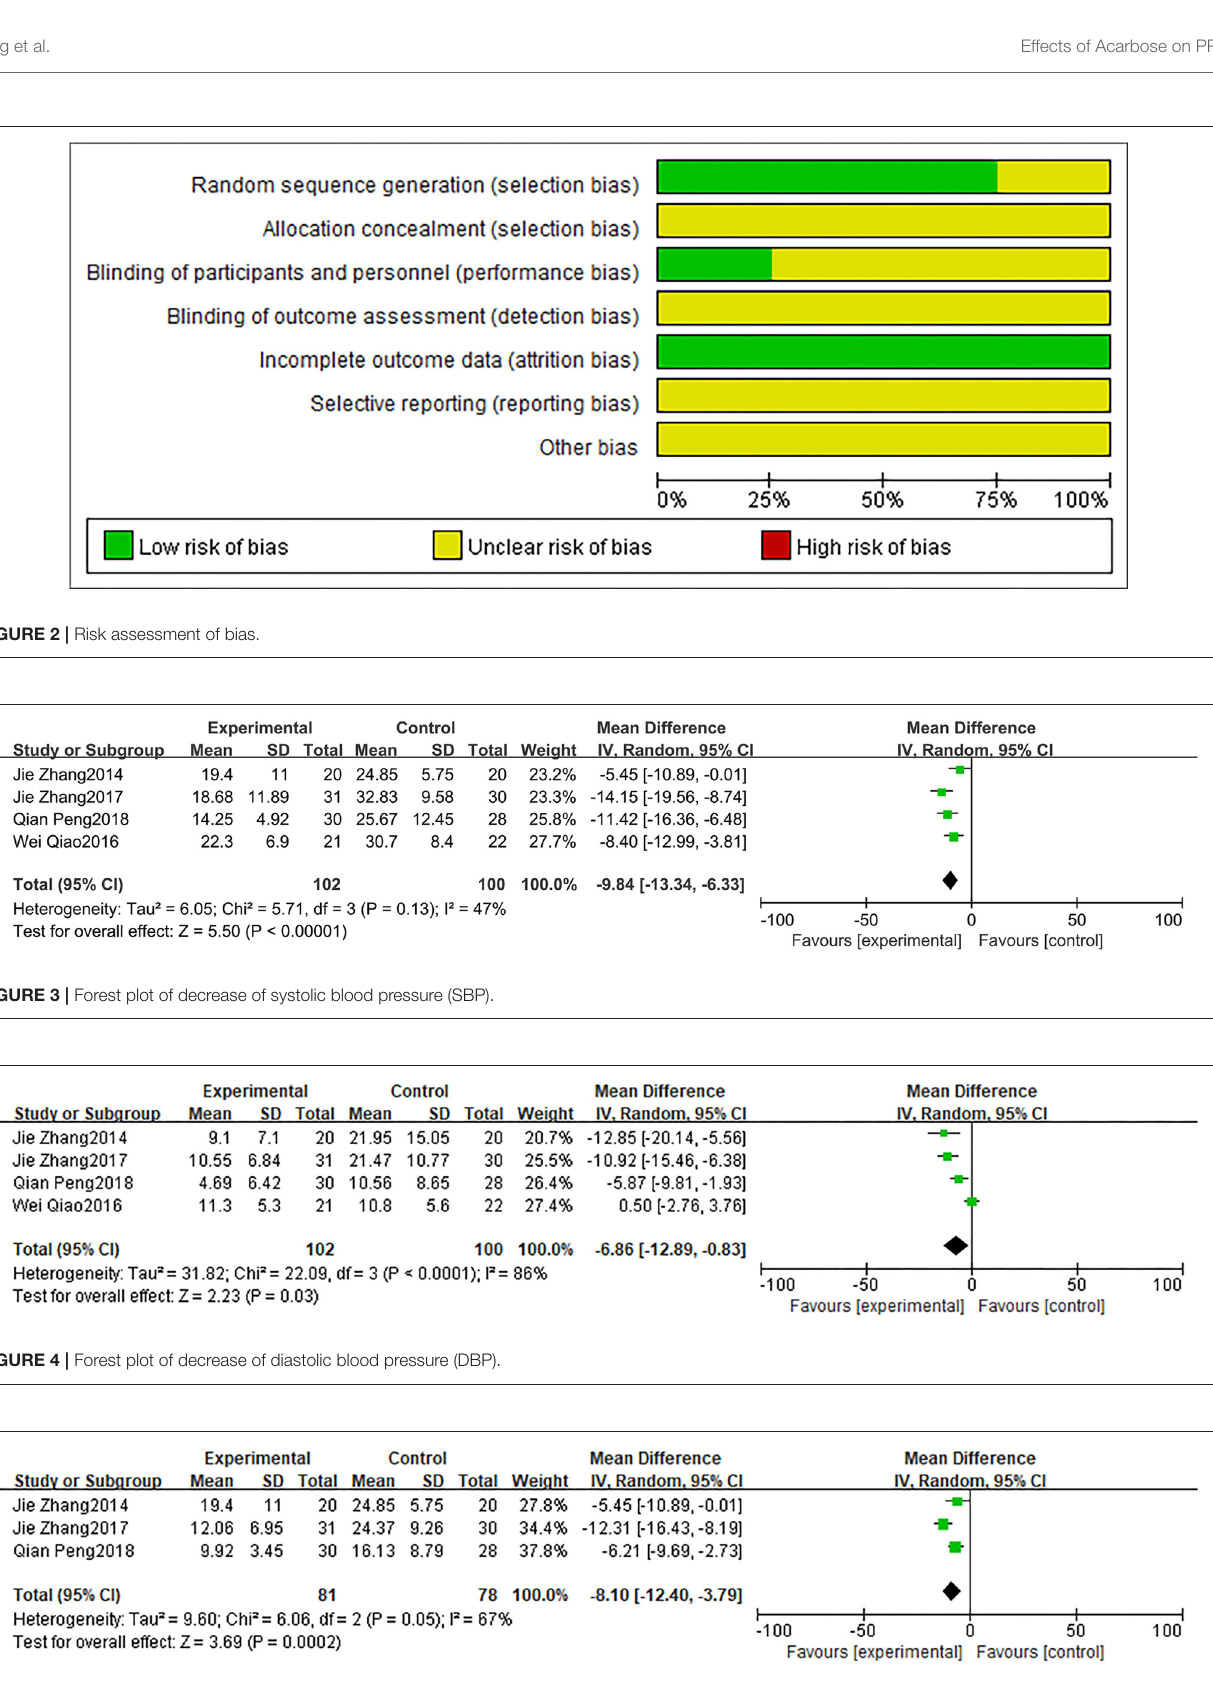
FIGURE 5 | Forest plot of decrease of mean arterial blood pressure